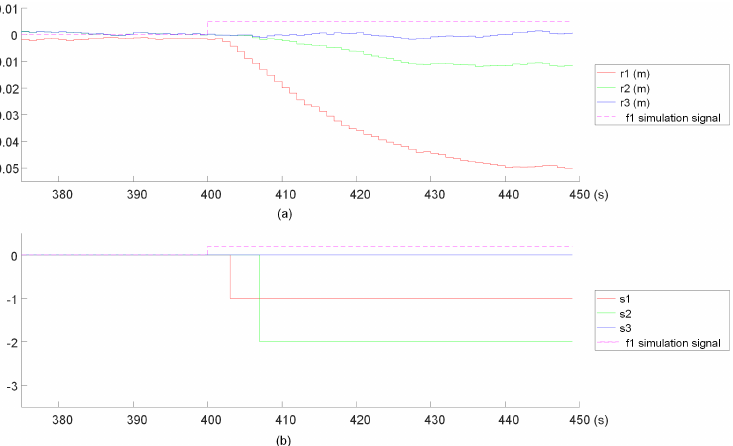
Figure 3. Examples of diagnosing the case of the f 1 fault: ( a ) residual values and ( b ) diagnostic signal